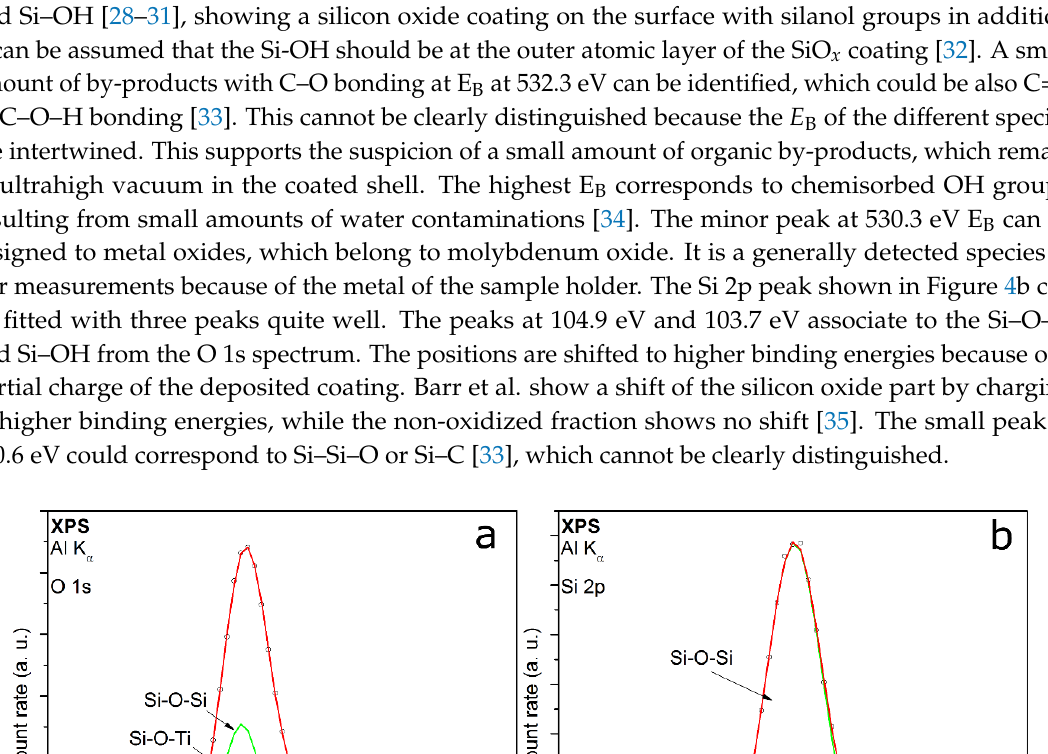
Table 1. Summarized XPS results from the particles coated with TEOS as precursor.